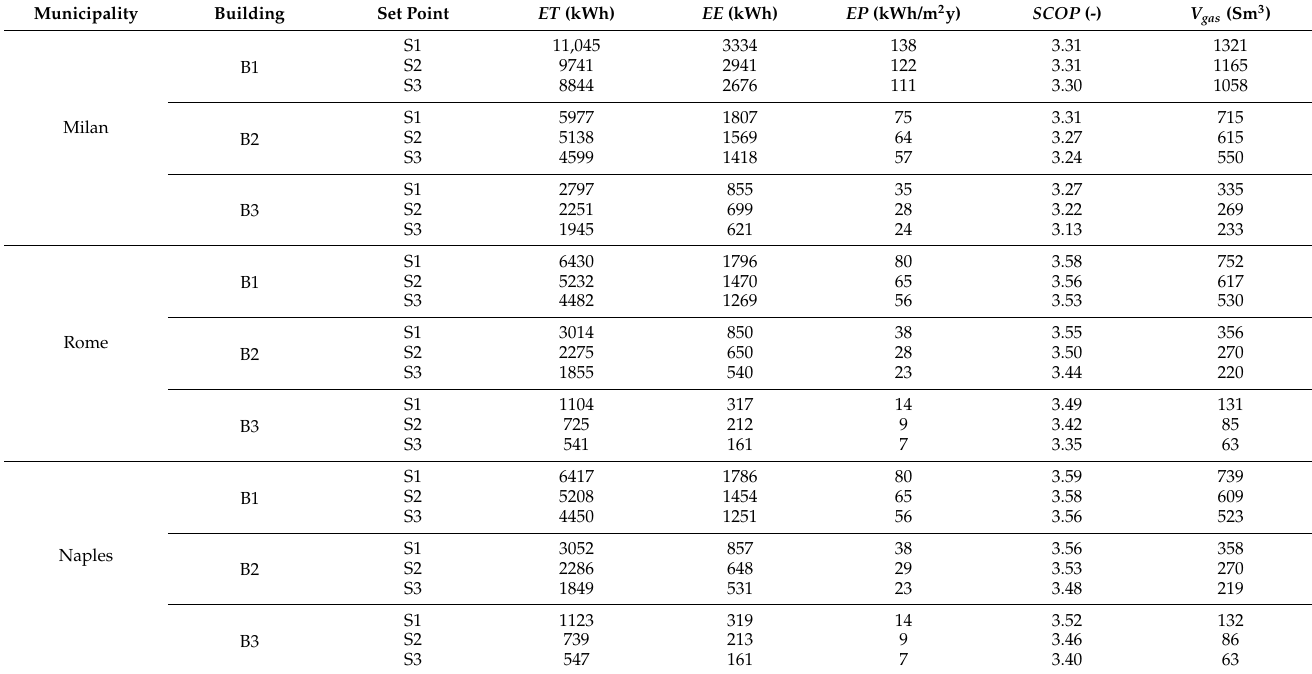
Table 6. Results from dynamic simulations performed. Values reported refer to the entire heating season.